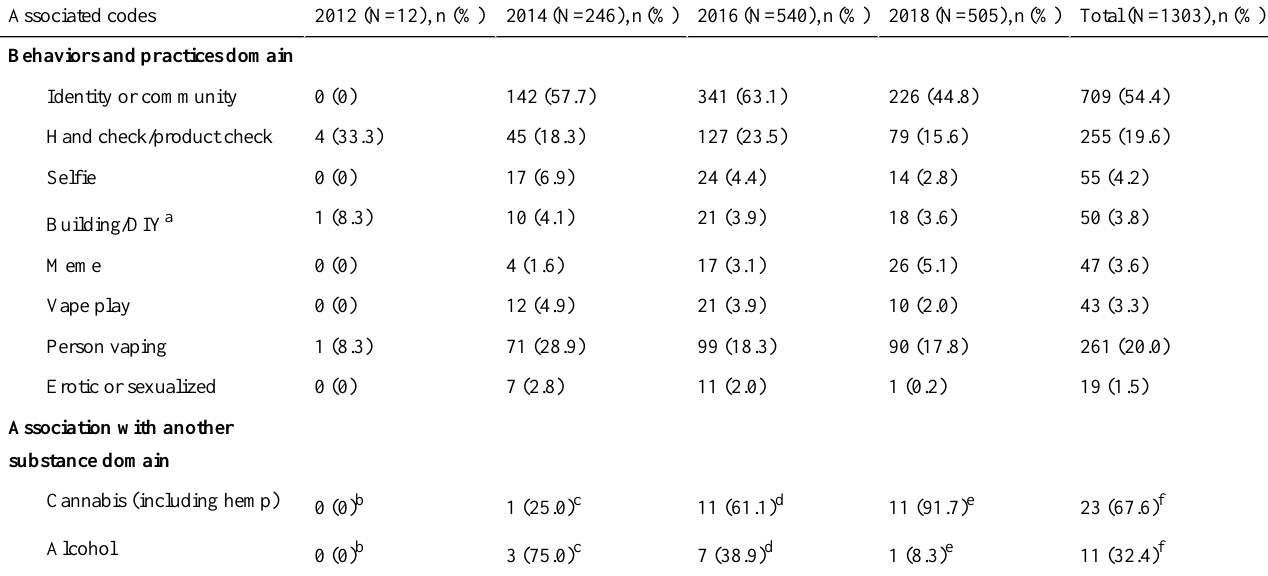
Table 6. Frequency statistics for each year corpus and the total sample within the “behaviors and practices” and “association with another substance” domains.